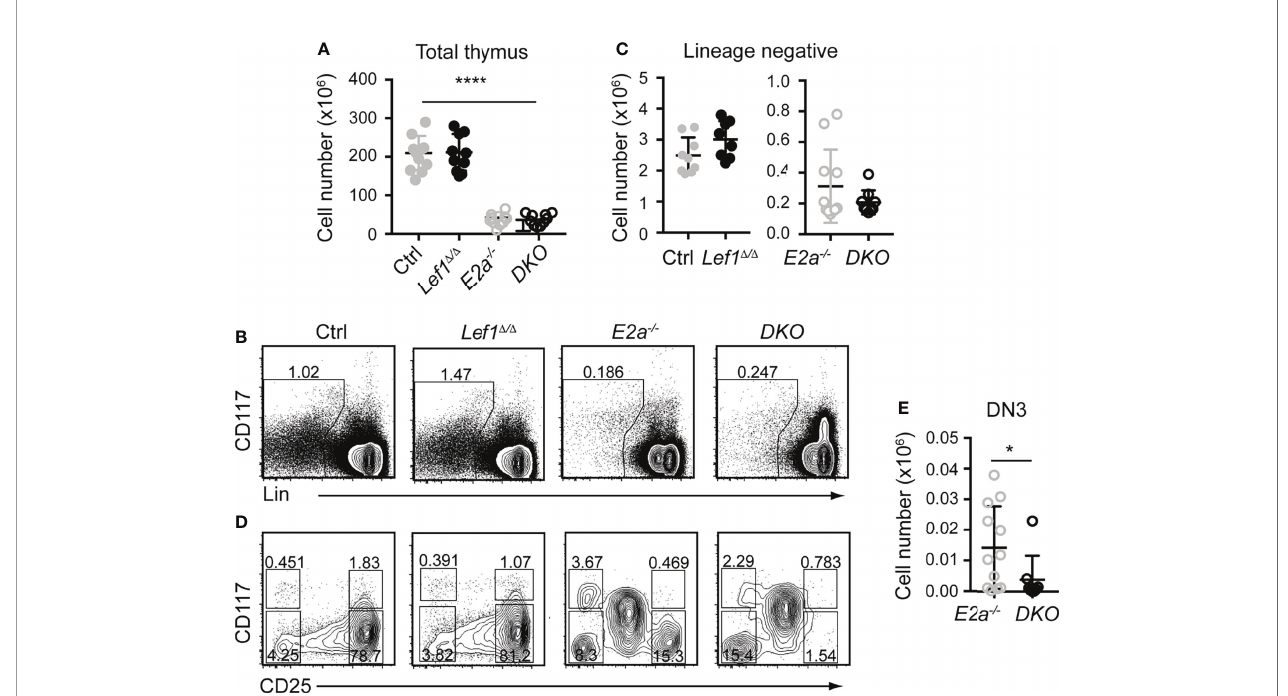
FIGURE 3 | T cell speci fi c deletion of Lef1 from E2a -/- mice does not impact thymocyte numbers but results in a loss of DN3 cells. (A) Total thymocyte numbers from mice of the indicated genotype. ****p < 0.001, Anova for multiple comparisons. (B) Flow cytometry showing Lineage markers (CD8, TCR b , TCR gd , CD11b, CD11c, NK1.1) and CD117 and the gating strategy for Lin - cells. (C) Lin - thymocyte numbers in mice of the indicated genotypes. (D) Flow cytometry showing CD25 and CD117 on Lin - thymocytes. (E) Summary of DN3 thymocyte numbers in mice of the indicated genotypes. Data is representative on more than 8 experiments *p < 0.05, Students t-test. Mice were between 5-7 weeks of